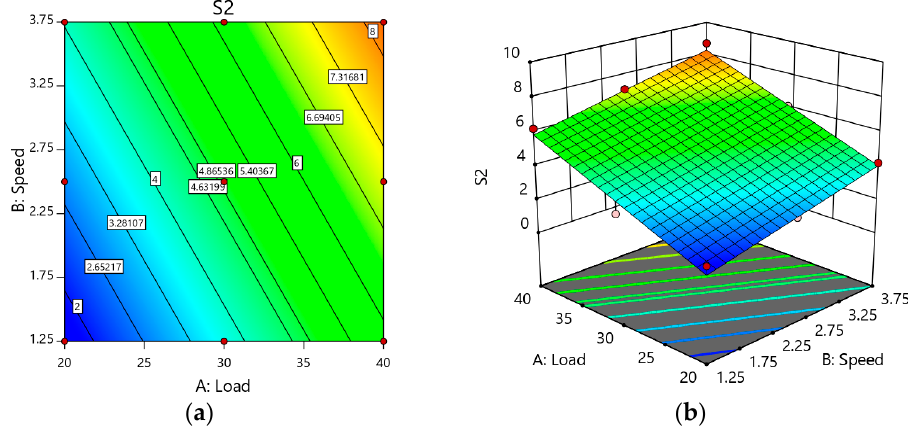
Figure 11. ( a ) 2D Response surface plot effect of load and speed on the weight loss of Sample S; ( b ) 3D Response surface plot effect of load and speed on the weight loss of Sample S2.